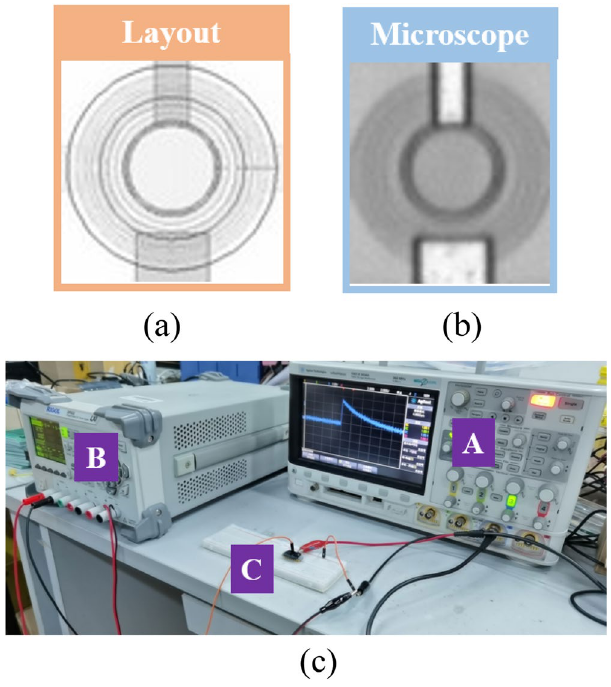
Figure 6. ( a ) The layout of VADTS. ( b ) The microscope image of VADTS. ( c ) The experimental platform of VADTS (A: oscilloscope, B: power supply, C: volatile avalanche diode threshold switching).